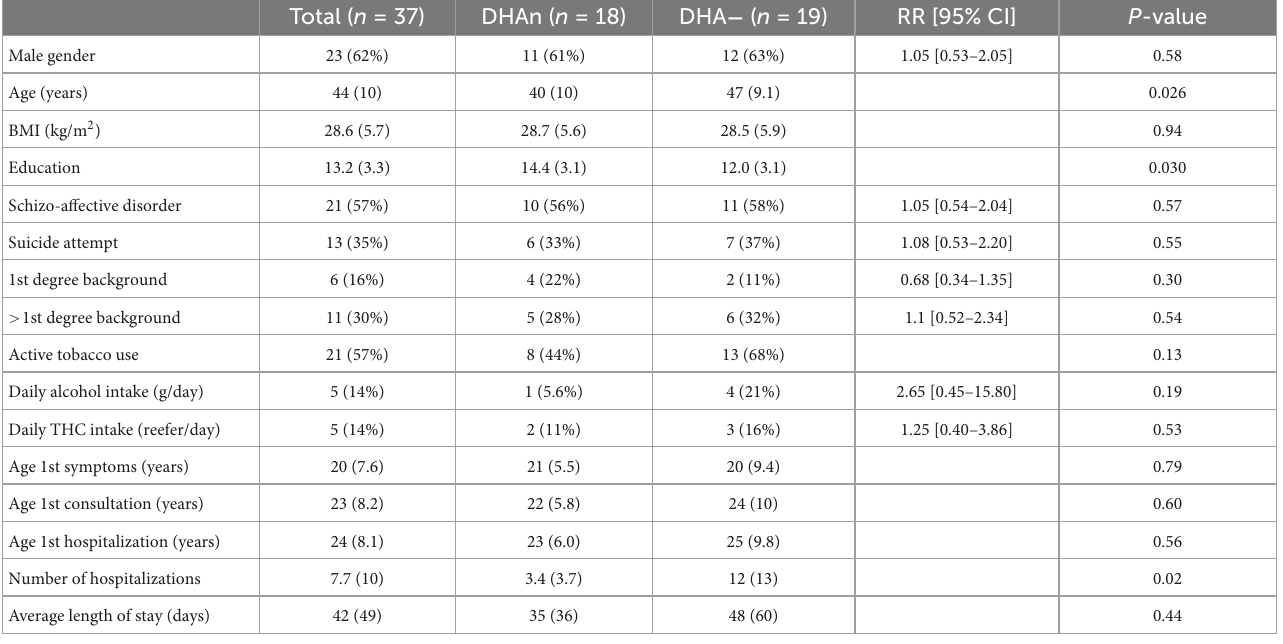
TABLE 1 Sociodemographic and clinical characteristics of the patient population, comparing the two groups DHAn and DHA −